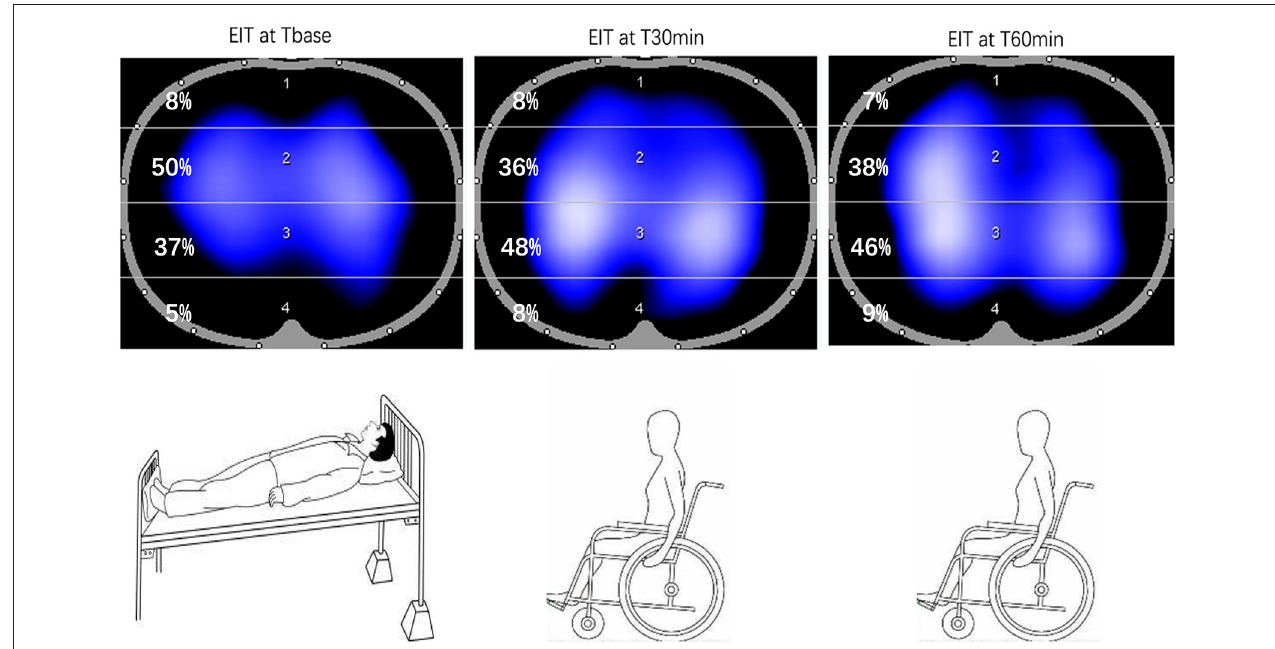
FIGURE 5 | EIT image from supine position (T base ) to sitting position on a wheelchair. T base : baseline, supine position in the bed, T30min: sitting position in the wheelchair after 30 min, T60min: sitting position in the wheelchair after 60 min.